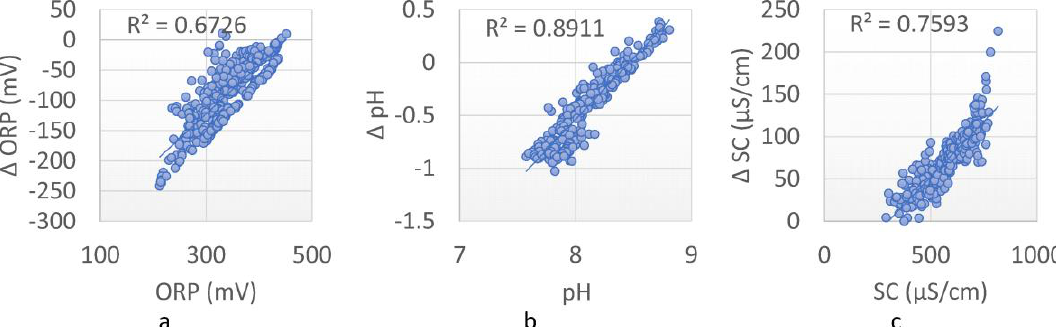
Figure 4. Comparative evolution of the difference between daily average values of the monitored parameters at Tişăuţi and Mihoveni in 2019 (the dotted red line is the linear trendline): ( a ) DO; ( b ) SC; ( c ) pH; ( d ) ORP; ( e ) temperature; ( f ) level.